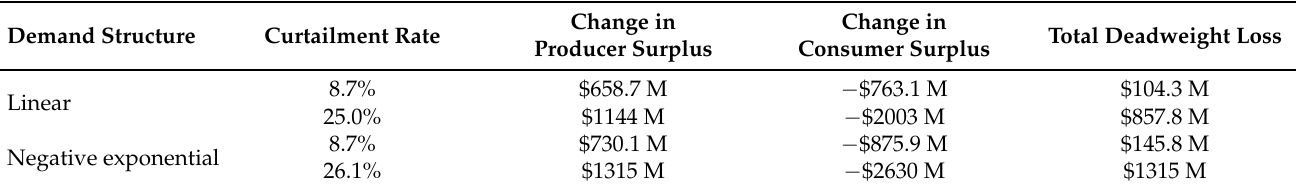
Table 7. Market Implications of Producer Surplus Maximizing